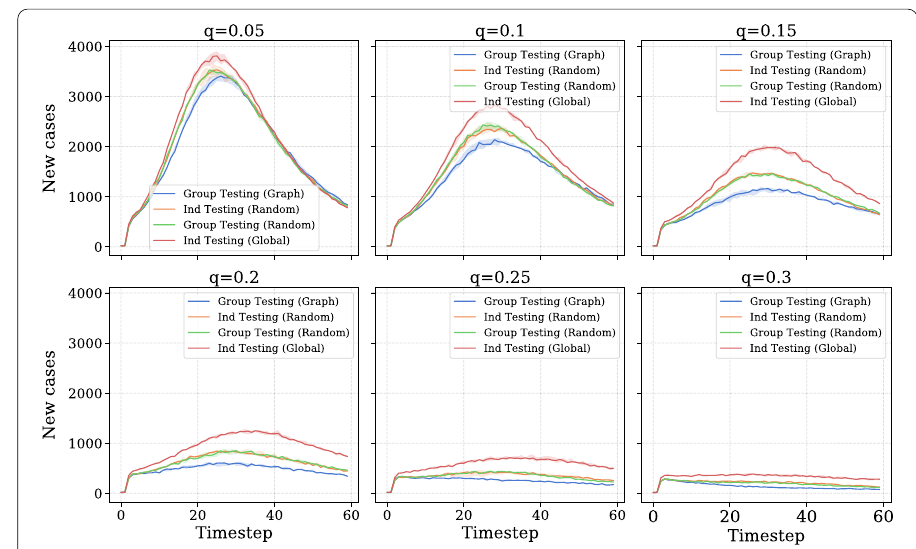
Fig. 5 Number of new cases at each timestep for a level of testing q . δ is fixed for all plots at 0.2